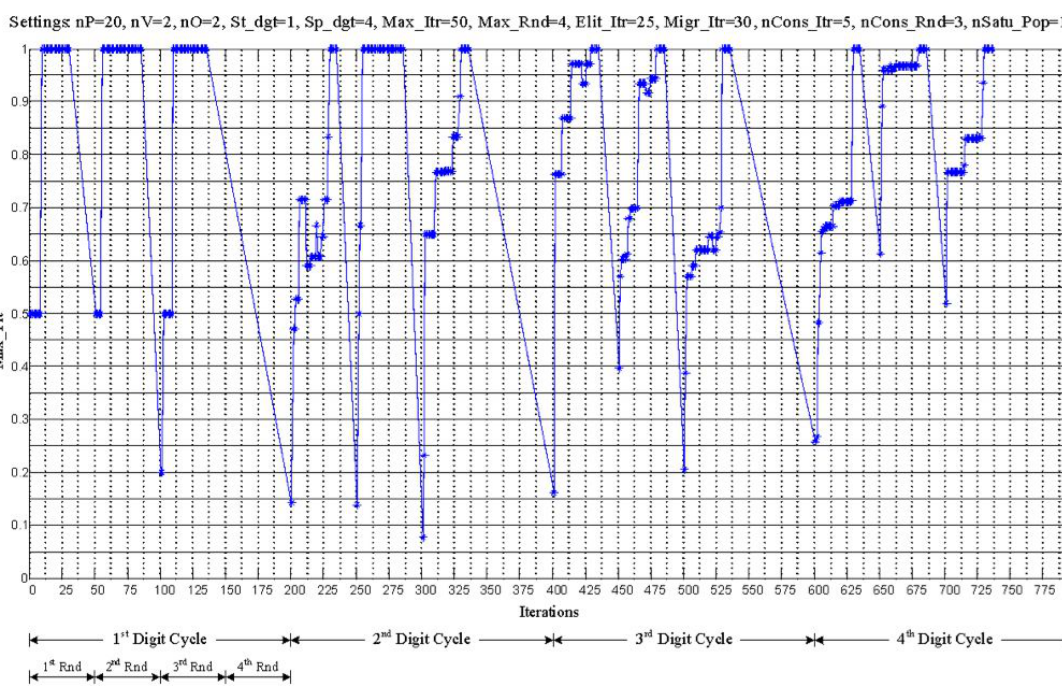
Figure 6: Flow of max Fit over iterations, for Effati and Nazemi Example